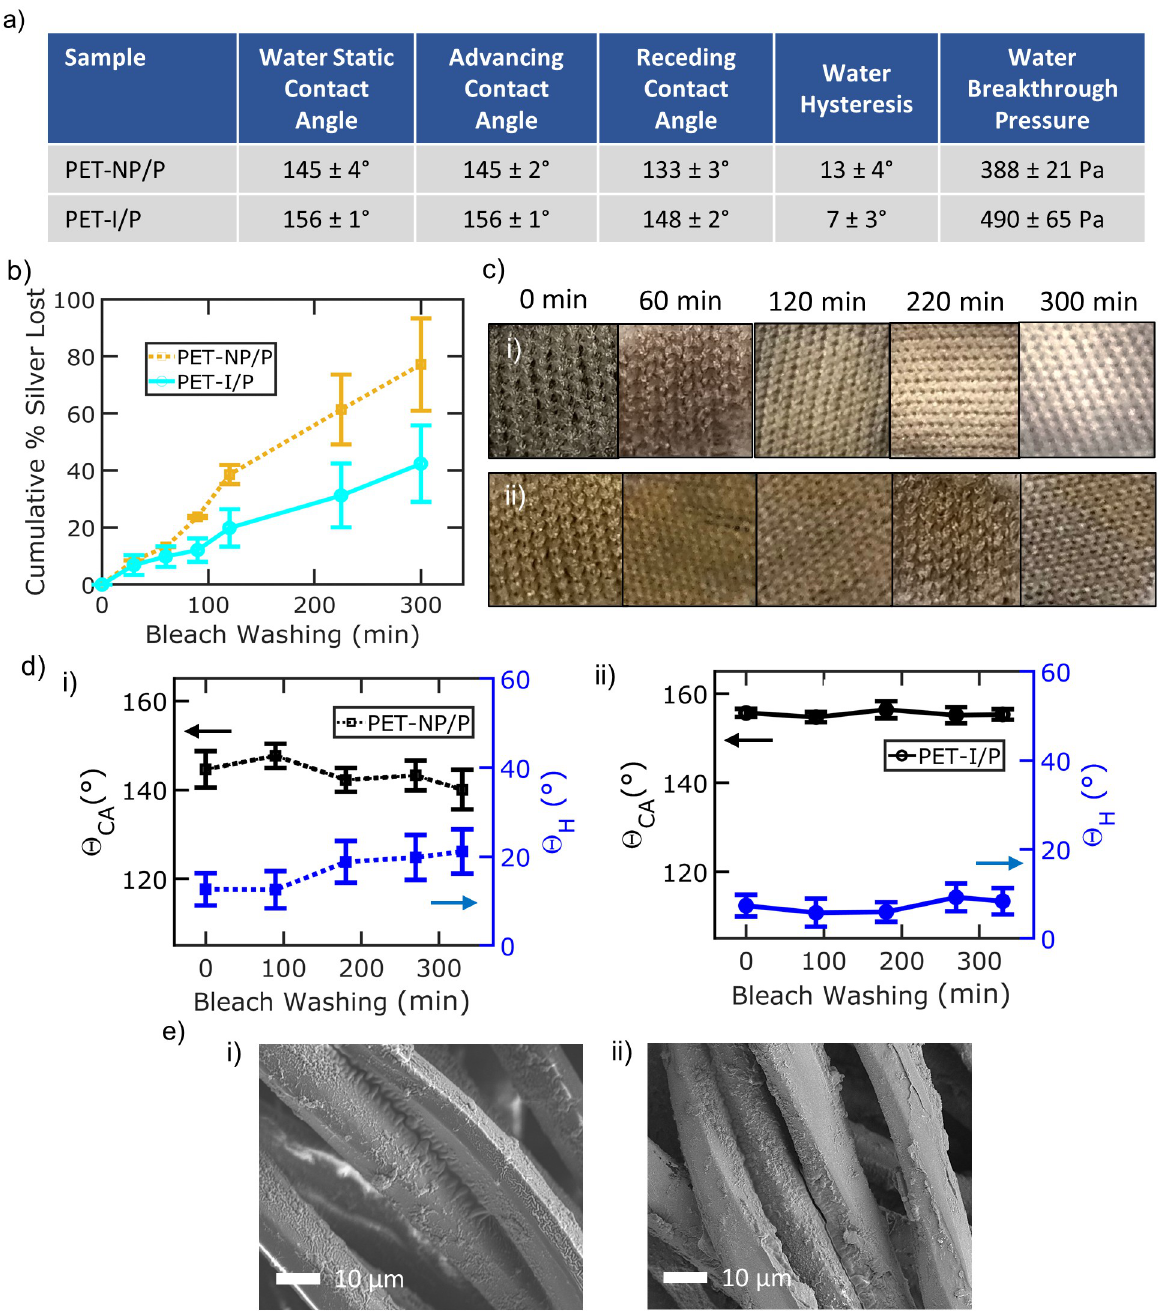
Fig 4. Wash Durability of samples with PDMS. a) Wetting characterization for PET-NP/P and PET-I/P samples b) Silver leaching analysis as a function of bleach washing time c) Optical images of (i) PET-NP/P and (ii) PET-I/P samples as a function of bleach washing time d) Water contact angle (black) and hysteresis (blue) as a function of ultrasonic bleach washing time for (i) PET-NP/P and (ii) PET-I/P. e) SEM images after 300 minutes of ultrasonic bleach washing time for (i) PET-NP/P and (ii)